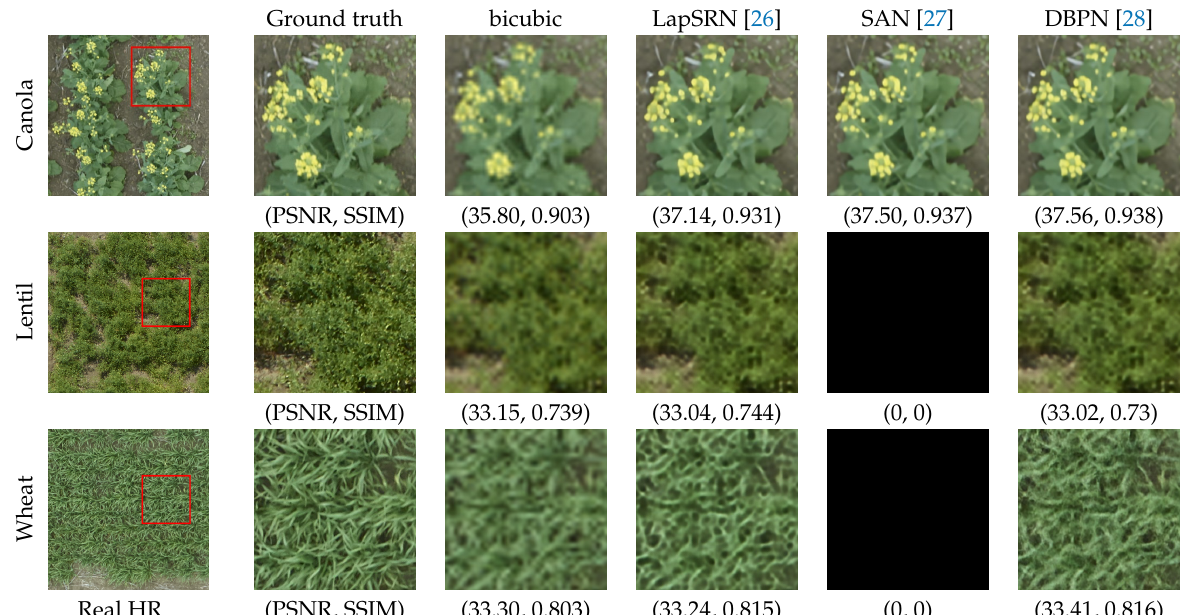
Table 4: Average SSIM for 8 super resolution with different algorithms for the synthetic-synthetic, synthetic-real, and × real-real experiments. The highest values are indicated in red .